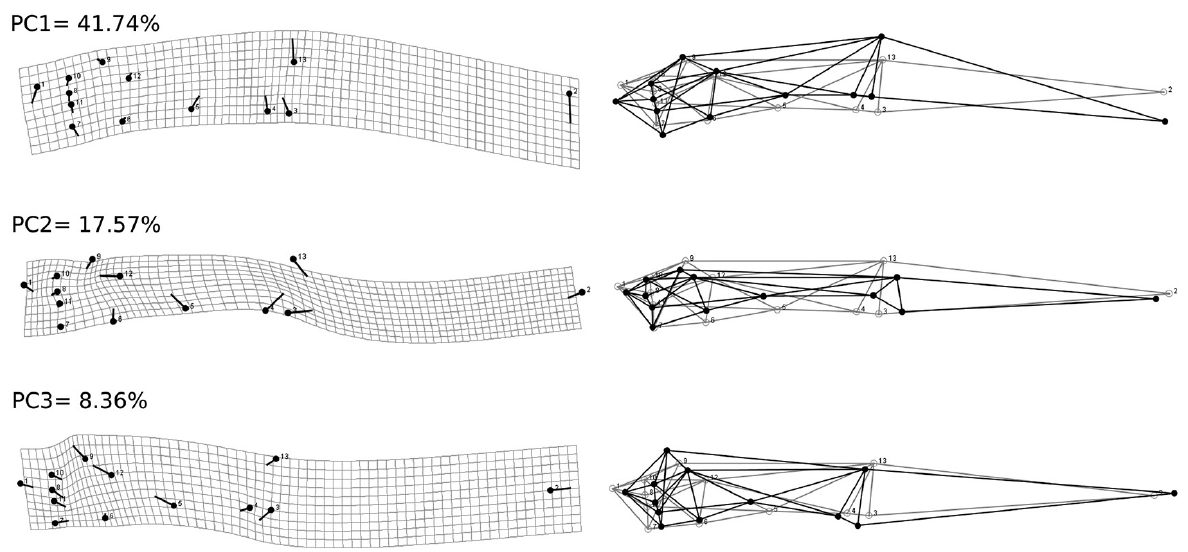
Fig. 5. – Transformation grids and wireframes representing the PCA shape changes associated with PC1, PC2 and PC3, showing changes for the relative position of each landmark. The grey outline represents the position of landmarks of the consensus, and the black outline represents landmark configurations.